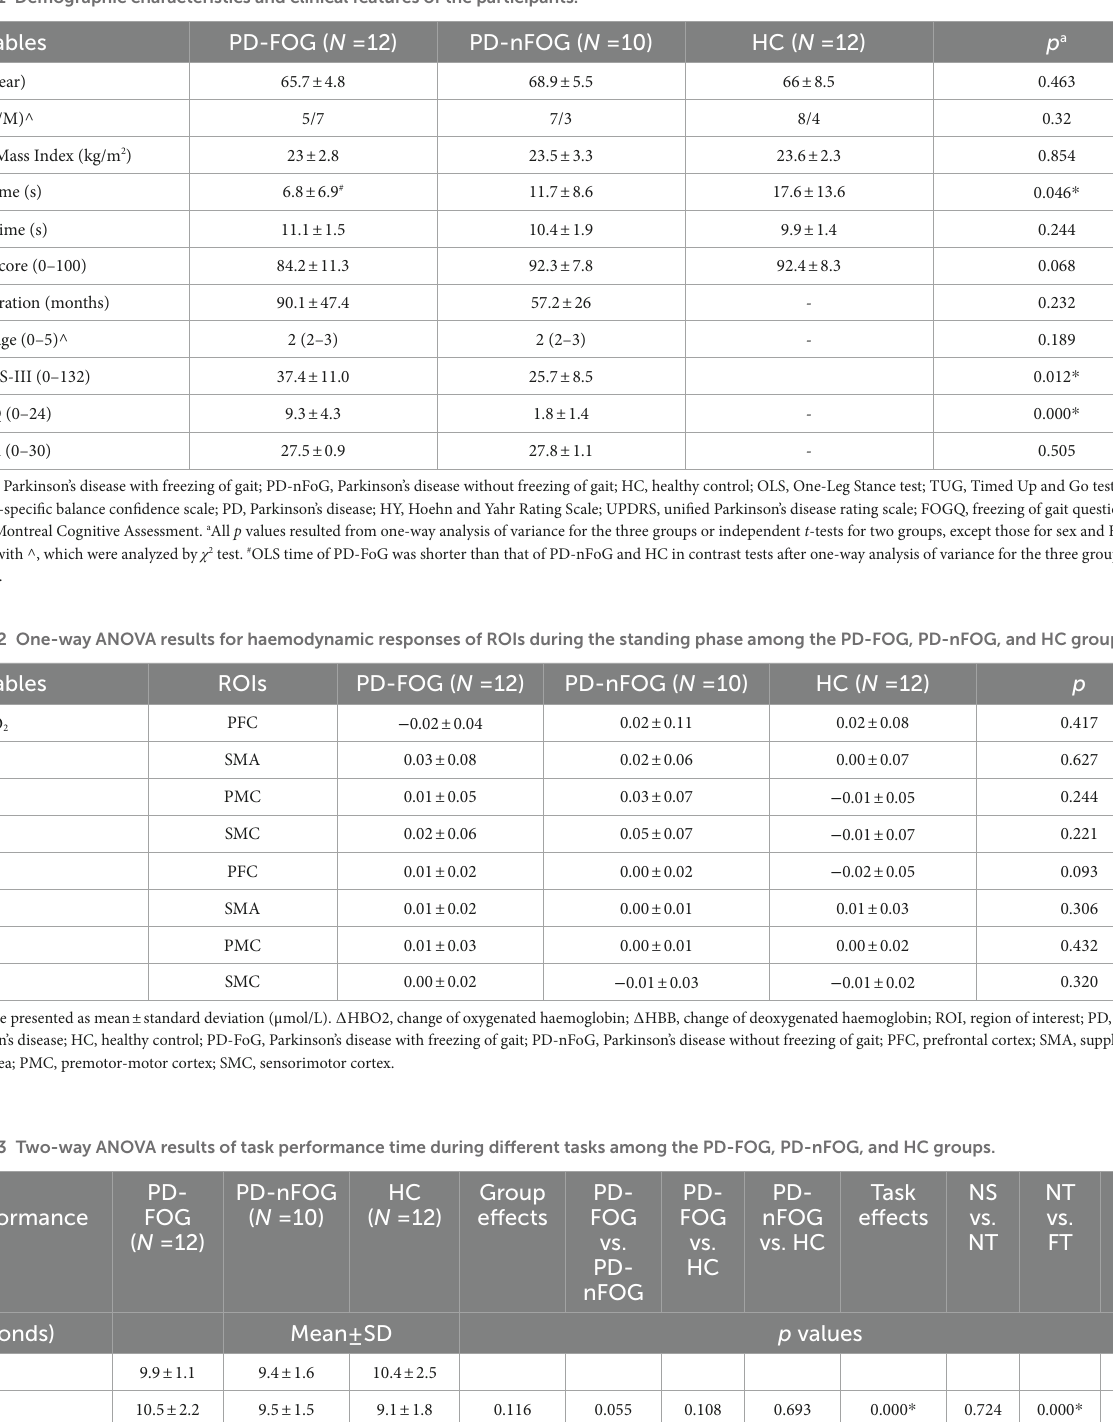
TABLE 1 Demographic characteristics and clinical features of the participants.